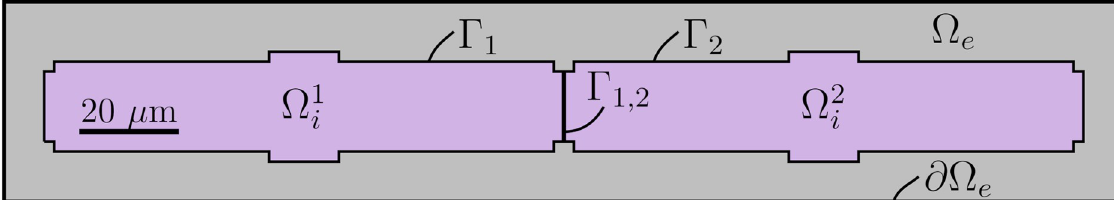
Fig 1. Illustration of a 2D version of the computational domain for two cells. The domain consists of an extracellular domain O e and two intracellular domains O 1 and O 2 with cell membranes Γ 1 and Γ 2 . The intracellular domains are connected by the intercalated disc denoted by i i Γ 1,2 , and the outer boundary of the extracellular domain is denoted by @ O e